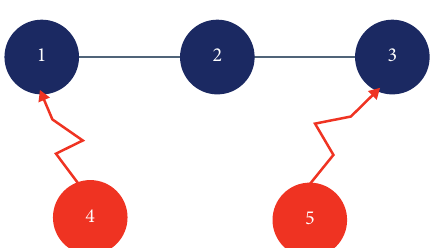
Figure 4: Star graph.